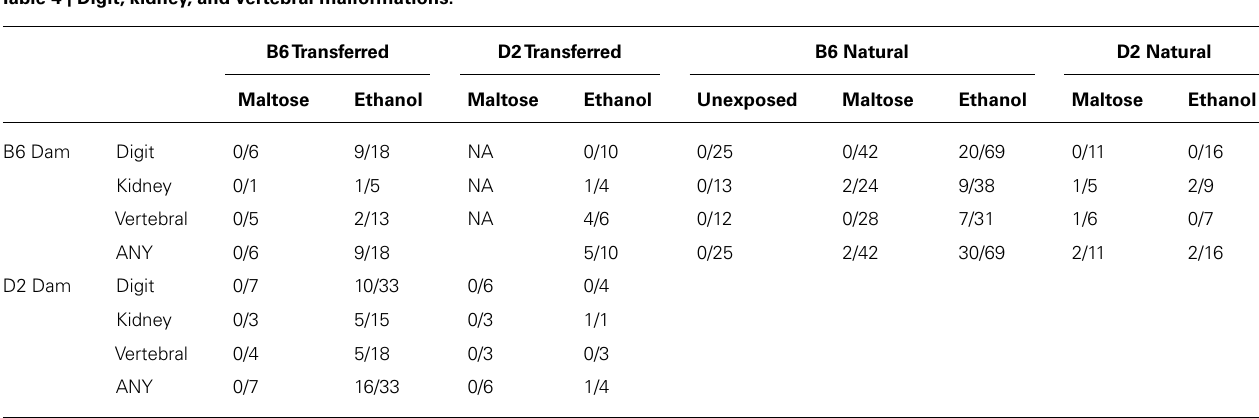
Table 4 | Digit, kidney, and vertebral malformations.